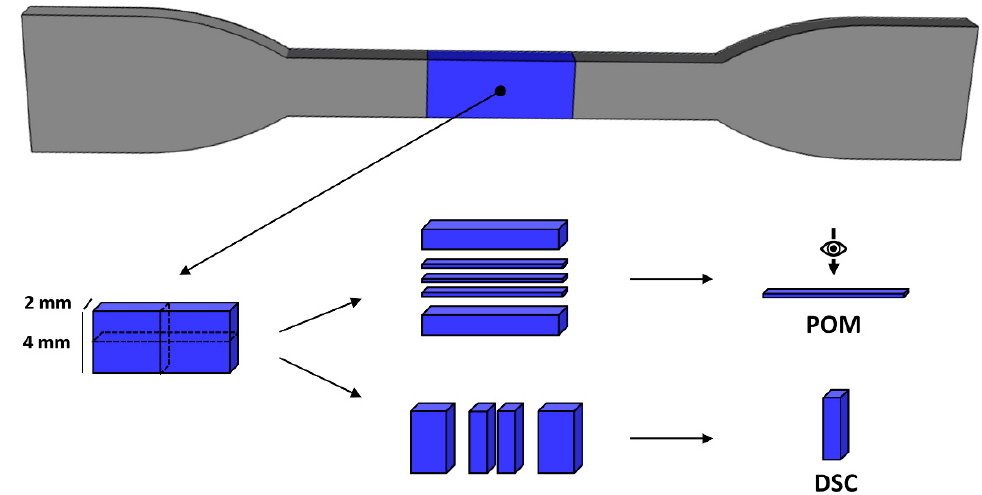
Figure 2. Dimensions of the dumbbell-shaped injection molded samples and cross-sections for POM and DSC analysis.